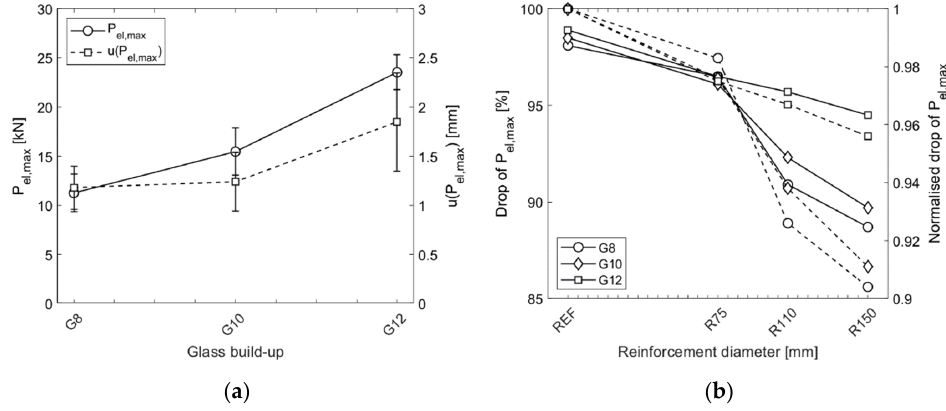
Figure 8. Results of experiments: ( a ) average force and displacement at glass breakage; ( b ) drop in P el,max force after glass breakage (normalised values are marked with dashed lines).